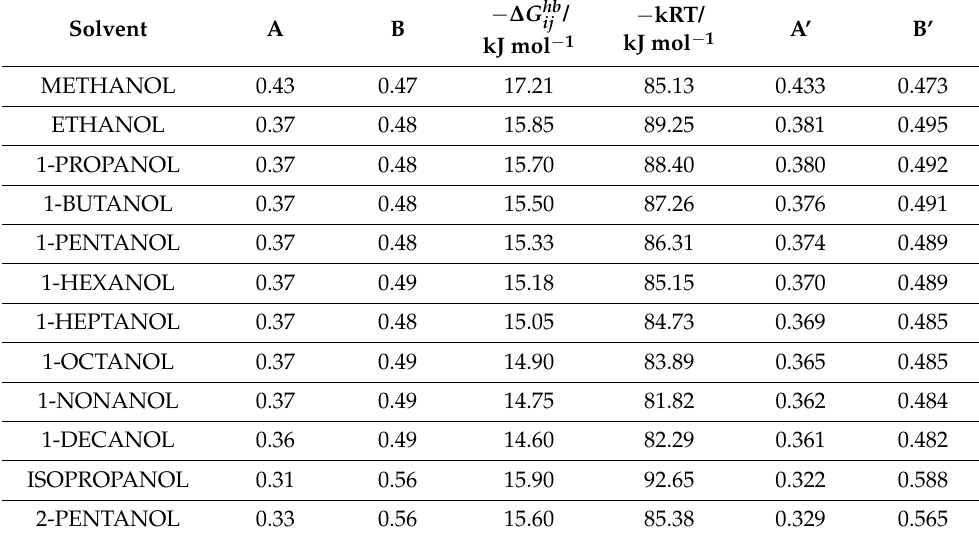
Table 4. The acidity and basicity LSER descriptors, A and B [16], the free energy change upon self-association, ∆ G hb , the corresponding kRT product, and the readjusted A’ and B’ descriptors to be ij used with a universal value of kRT = 84